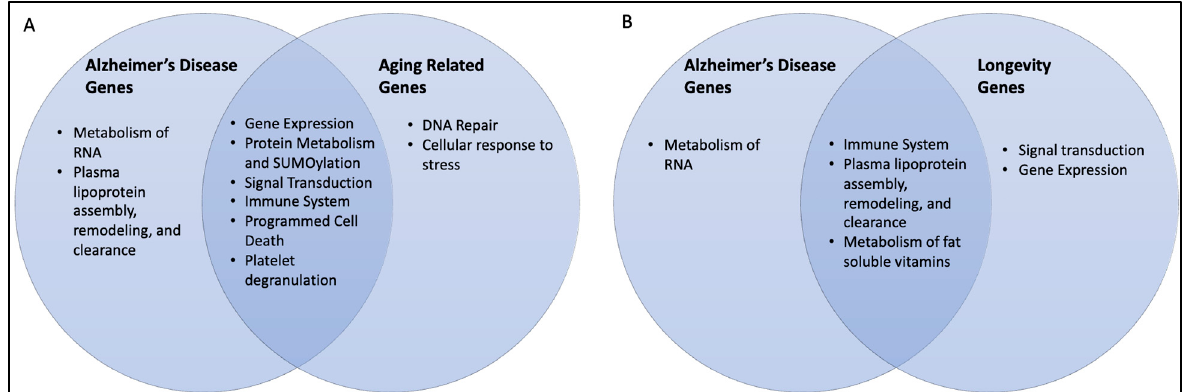
Figure 6. Venn diagrams of overlapping pathways: ( A ) Alzheimer’s genes and aging-related genes and ( B ) overlapping Alzheimer’s genes and longevity genes. The pathways shown in Tables 1–3, 5, and 6 were used.